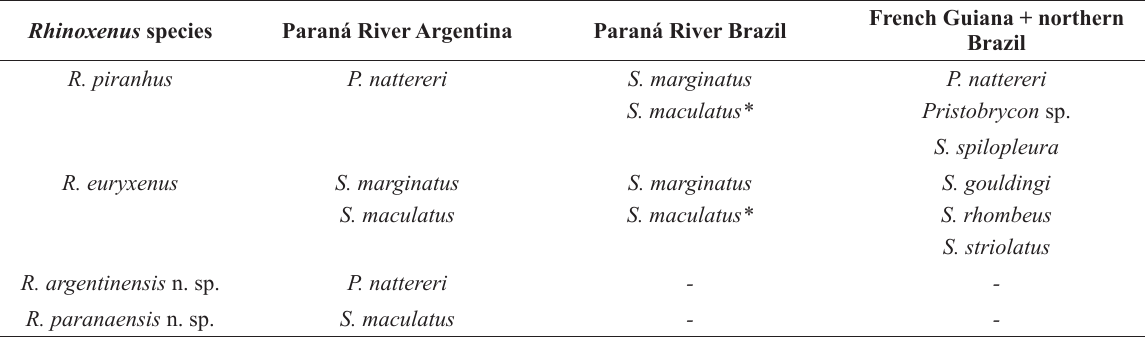
Records of hosts and localities of Rhinoxenus Kritsky, Boeger and Thatcher, 1988 species parasitizing piranhas from South America